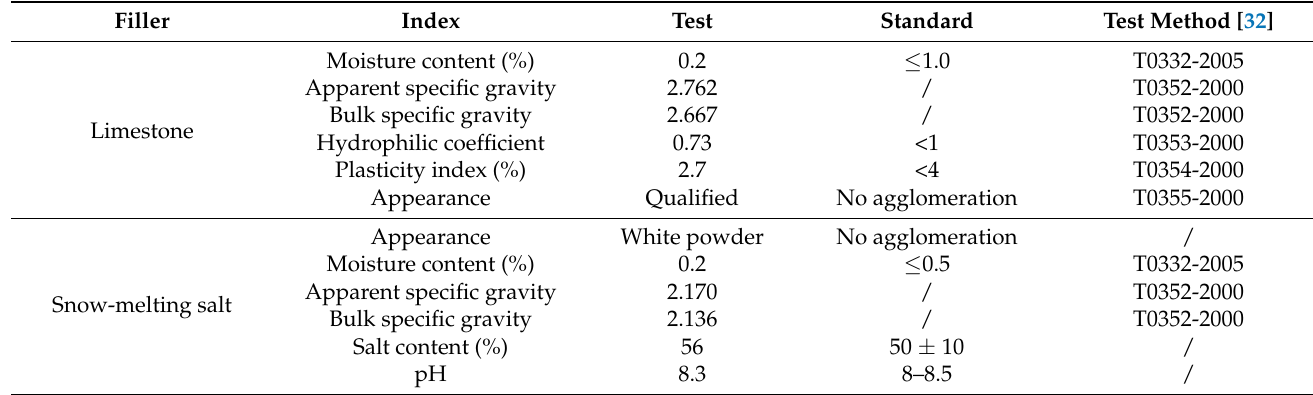
Table 3. Basic indicators of the two fillers.